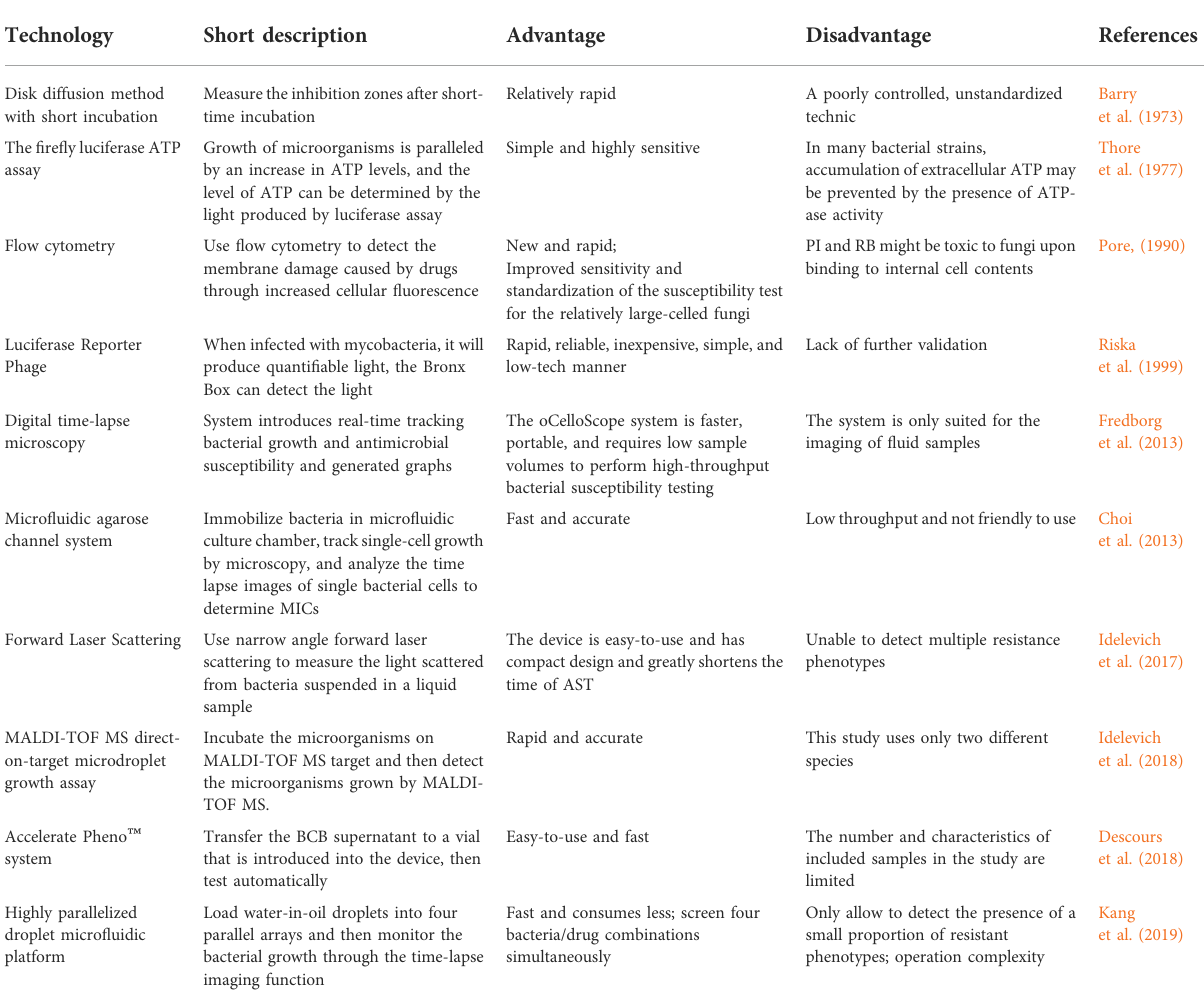
TABLE 1 Brief summary of different phenotypic detection